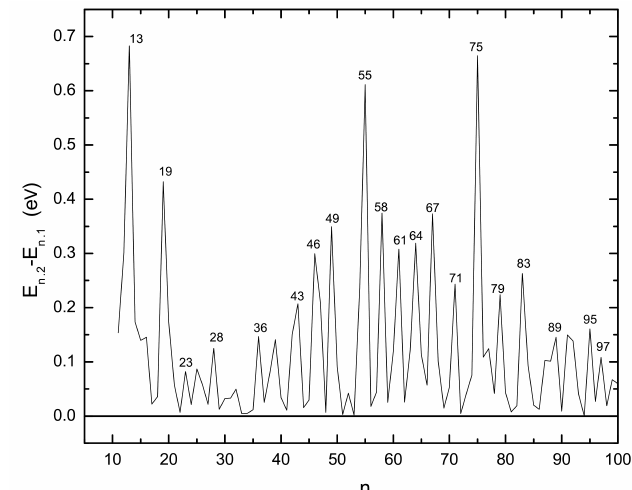
Figure 7. The difference between energies of energetically first and second lowest lying isomers of Ag clusters versus the number of atoms in the cluster as found in the EAM